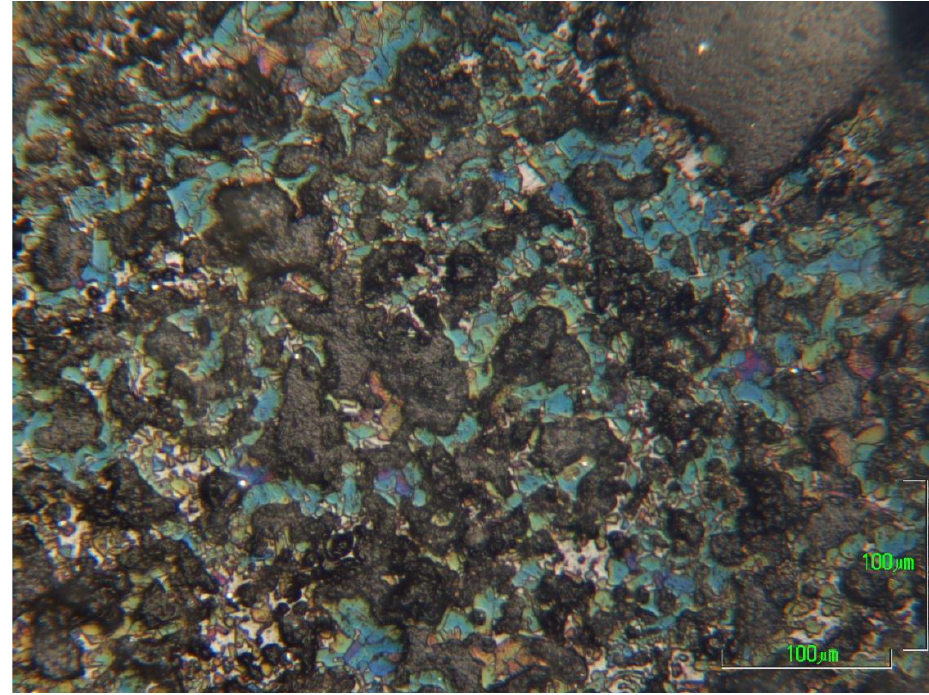
Figure 11. Image of optical microscopy of P2 65A_1340 .